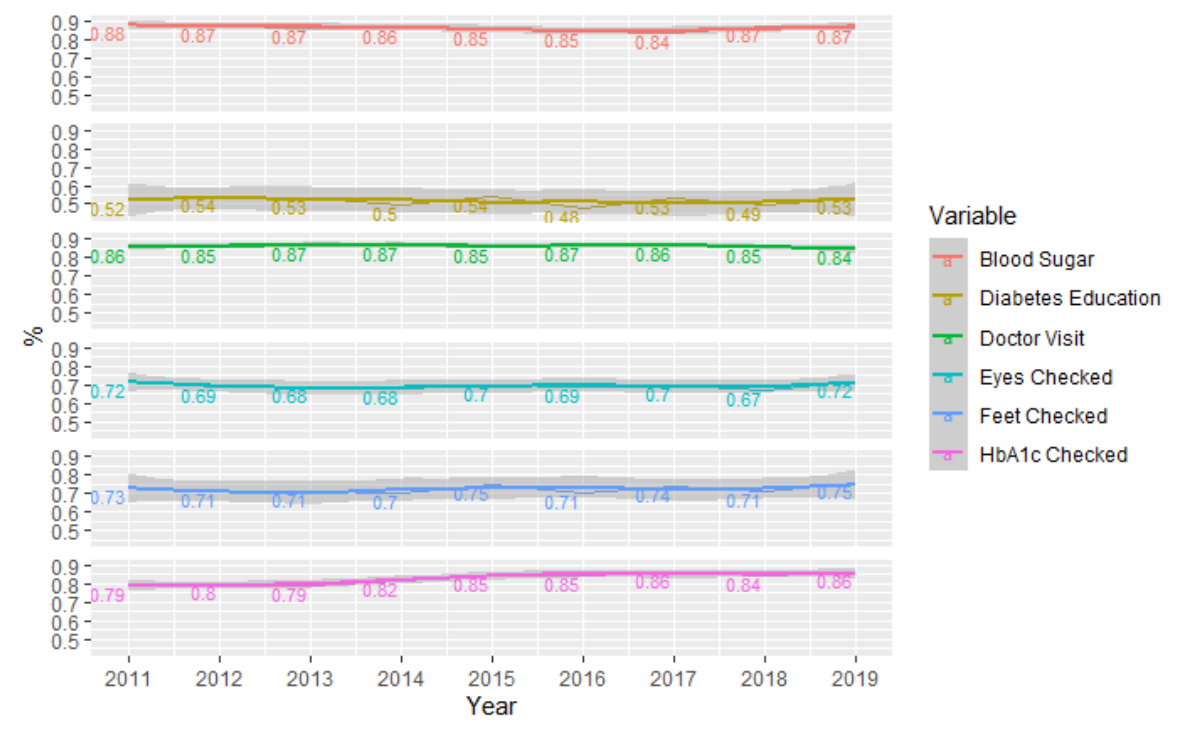
Figure 2. Plot of weighted diabetes management variables over time.